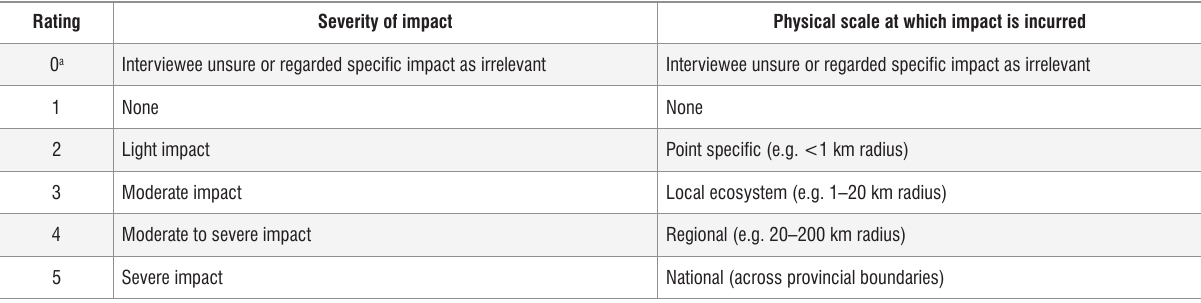
Table 1: An explanation of ratings attributed to the severity and scale of impacts on different biophysical elements and solar power plant components Severity of impact Physical scale at which impact is incurred Interviewee unsure or regarded specific impact as